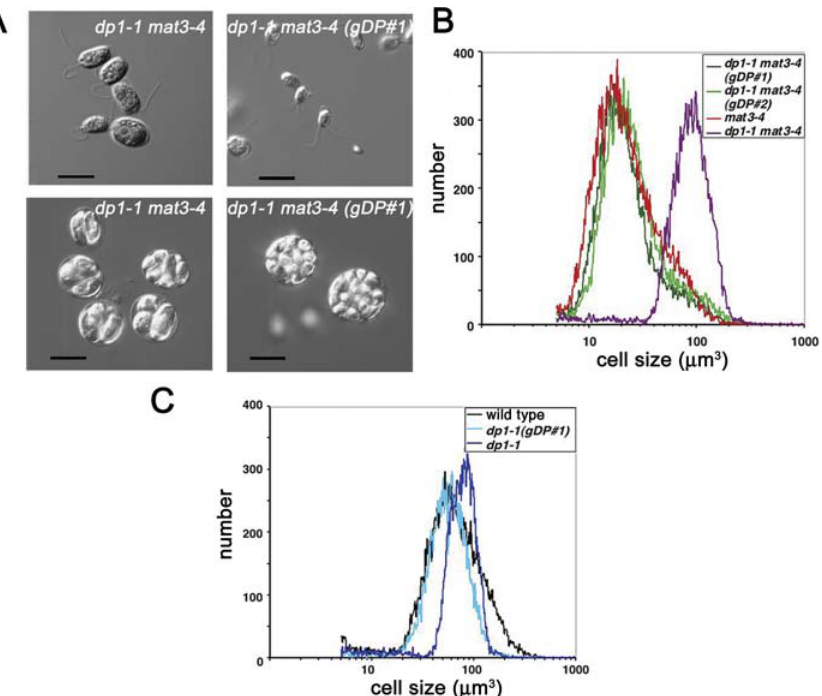
Figure 5. Complementation of dp1–1 (A) Nomarski images of dp1–1 mat3–4 double mutants with and without a complementing genomic construct containing the wild-type DP1 gene (gDP#1). Top panels show dark-shifted cells, and bottom panels show postmitotic clusters. Scale bar ¼ 10 l m. (B) Size distributions of dark-shifted cells from mat3–4 , dp1–1 mat3–4 , and two independently generated dp1–1 mat3–4 transformants that are complemented with gDP1 (gDP#1 and gDP#2). (C) Size distributions of dark-shifted wild-type, dp1–1, and complemented dp1–1 (gDP#1) strains. DOI: